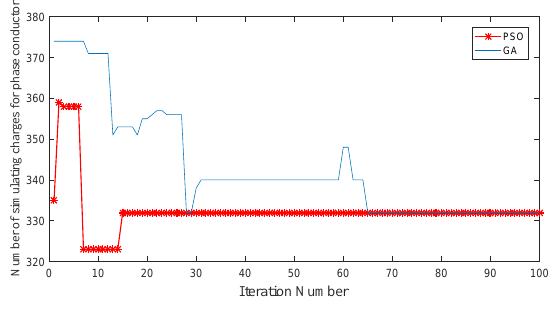
Figure 13. The relationship between iteration number and number M of